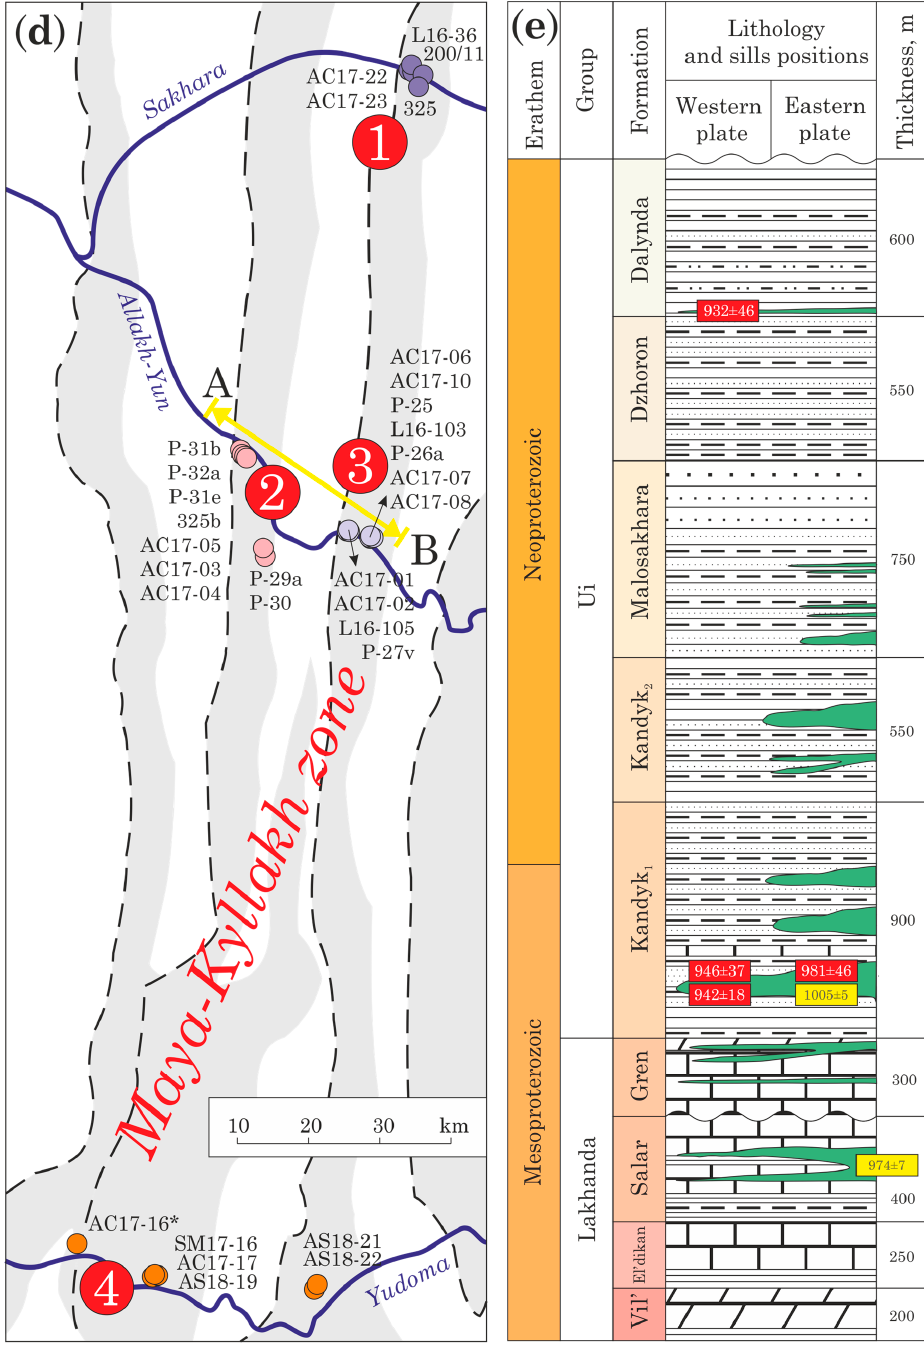
Figure 1. ( a , b , d ) Location maps, ( c ) cross-section (after [12], modified), and ( e ) composite stratigraphic section (after [12–14] and observations by authors) of the Meso- and Neoproterozoic succession in the Maya-Kyllakh zone. Sample locations, numbers, and specific colors used in the following diagrams are shown in Figure 1d. U-Pb baddeleyite and Sm-Nd isochron ages in Figure 1e are from